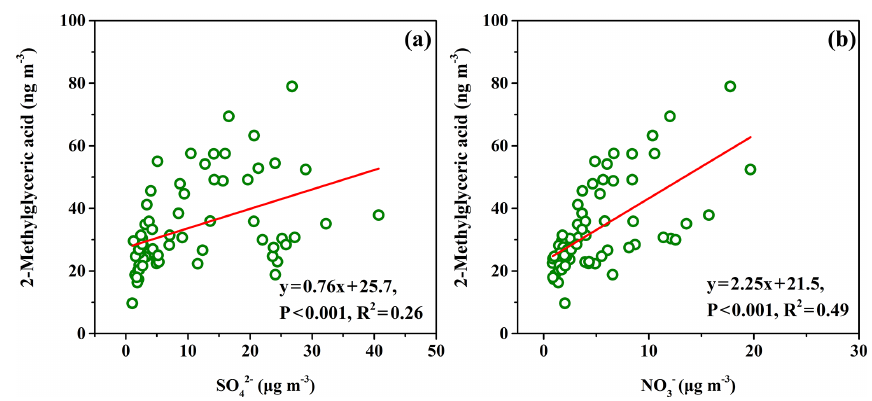
Figure 8. Concentration correlation between (a) 2-methylglyceric acid (2-MGA) and SO 2 − aerosols from Bode, Kathmandu.